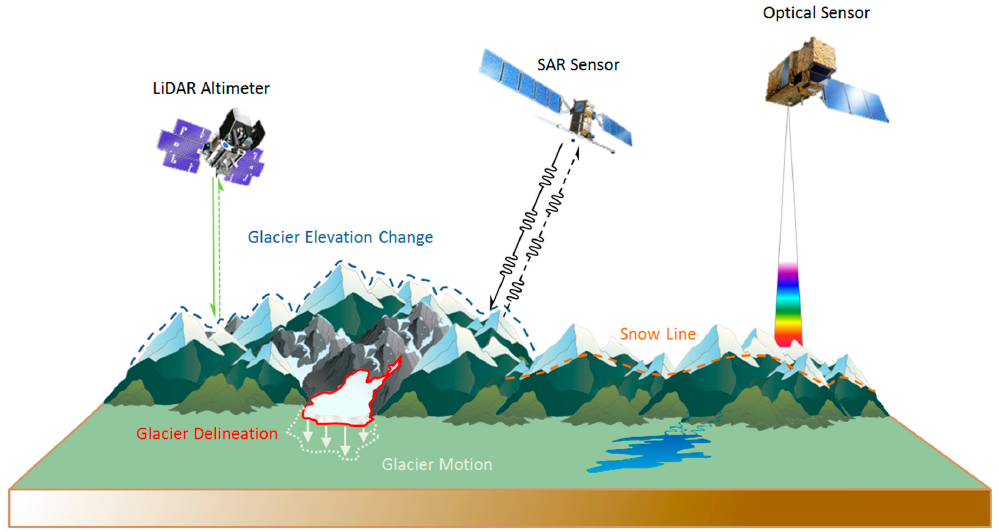
Figure 3. Thematic sketch of glacier monitoring by spaceborne earth observation.